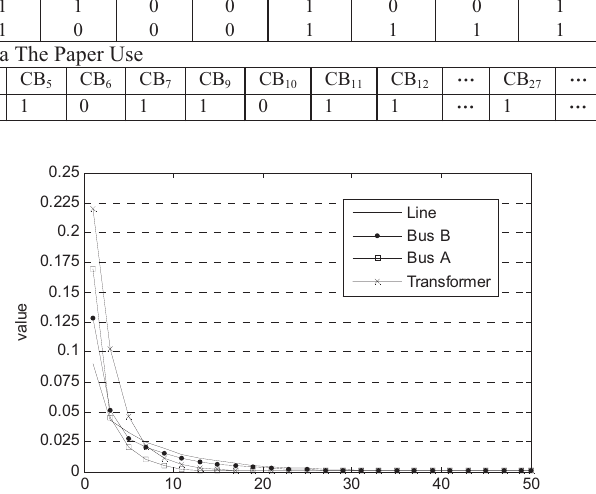
Table 4 One of Fault Data The Paper Use